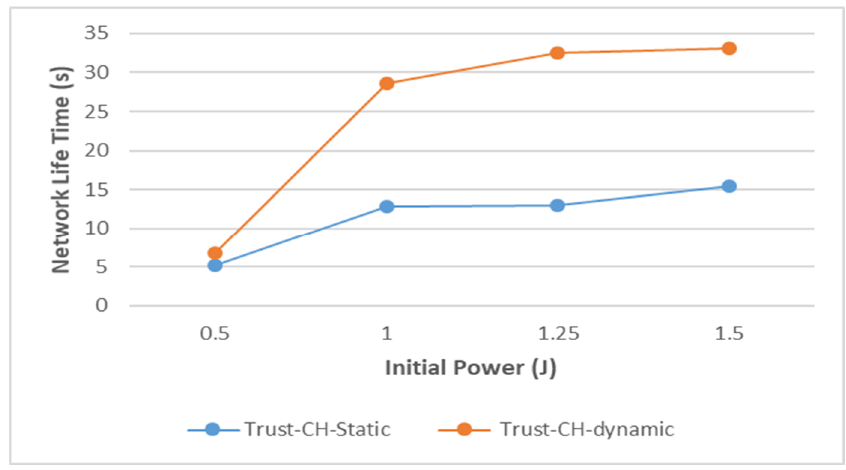
Figure 9. The Trust-CH network lifetime analysis.